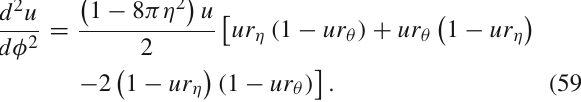
being “.” the derivative with respect to an affine